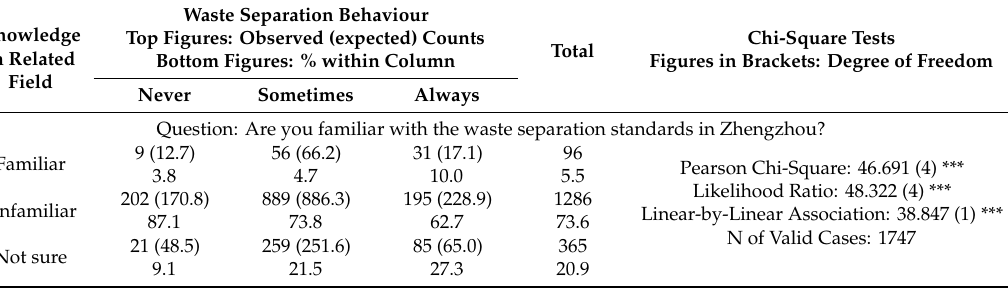
Table 6. Knowledge in waste separation and waste separation